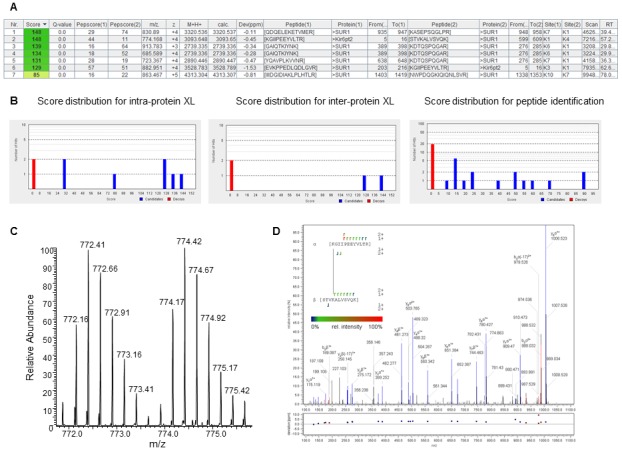
Mass spectrometric identification of a chemical crosslink between Kir6.2 peptide KGIIPEEYVLTR (5-16) and SUR1 peptide STVKALVSVQK (599-609) using CBDPS.(A) Table listing the top seven scoring MS/MS spectra for two inter-protein (Kir6.2/SUR1; Nr. 2, 6) and four intra-protein (SUR1/SUR1; Nr. 1, 3, 4, 5, 7; Note Nrs. 3 and 4 are the same crosslink with different z values) peptide crosslinks identified by MeroX software. Q-values of zero were calculated for all identified crosslinks using a decoy database of shuffled sequences from a database of 116 common protein contaminants, indicating a false discovery rate below 1%. All precursor ions for identified crosslinks also had mass errors below two ppm. (B) Score distribution histograms for identified intra- and inter-protein crosslinks and peptide identifications (red bars = decoy matches to shuffled sequences, blue bars = matches to correct sequences). (C) Precursor ion spectrum for +four charge state crosslink between Kir6.2 (5–16) and SUR1 (599–609) showing both light and heavy forms of the crosslinked peptide resulting from the 50:50 mixture of the H8 and D8 forms of CBDPS. Only the heavy form of each 8.05 mass shifted pair was selected for MS/MS analysis. (D) Annotated MS/MS fragment ion spectrum for the +four charge state crosslink between Kir6.2 (5–16, α-peptide) and SUR1 (599–609, β-peptide). Insert shows the matched y- and b-ions along the α- and β-peptide backbones, their relative intensities and their charge states. The graph at the bottom shows the mass errors of matched fragment ions, which all had errors below 10 ppm.